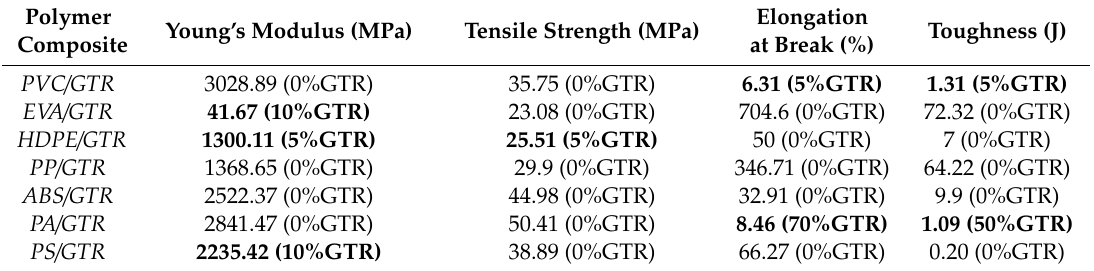
Table 3. Highest values of each property analyzed, and the composite regarded (size particle of GTR < 200 µ m).